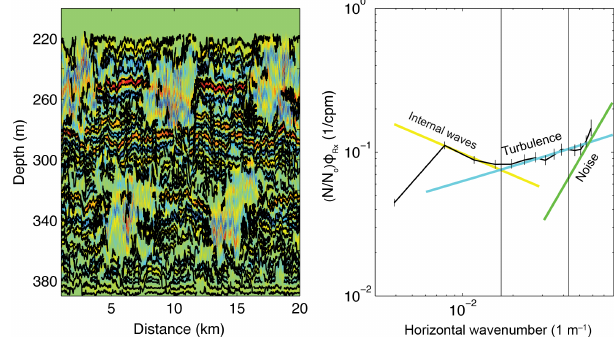
Figure 11. Synthetic seismic data and data transform.